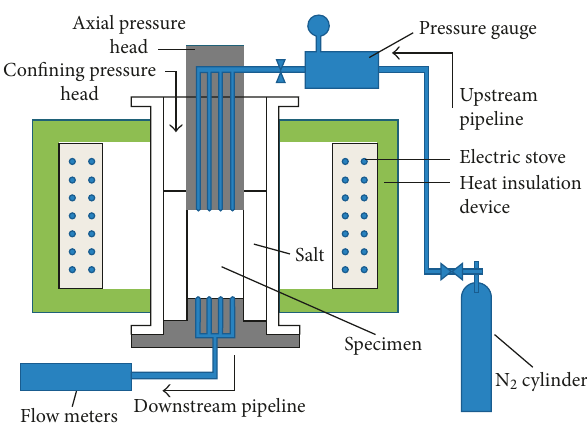
Figure 1: Illustration of the solid-head-coupled triaxial rock permeability testing system by Taiyuan University of Technology, China.